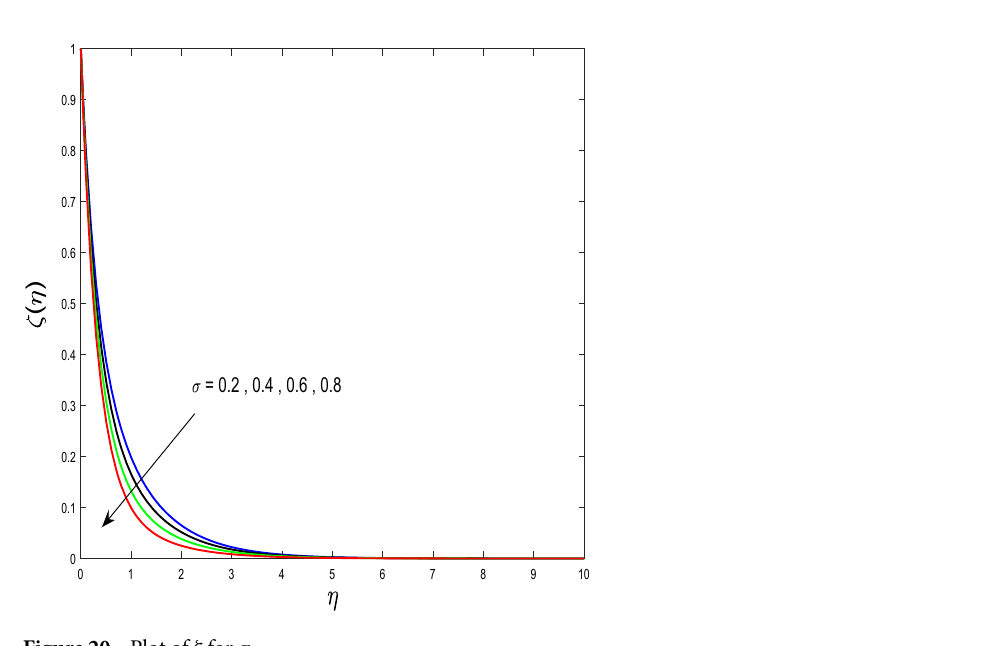
Figure 20. Plot of ξ for σ